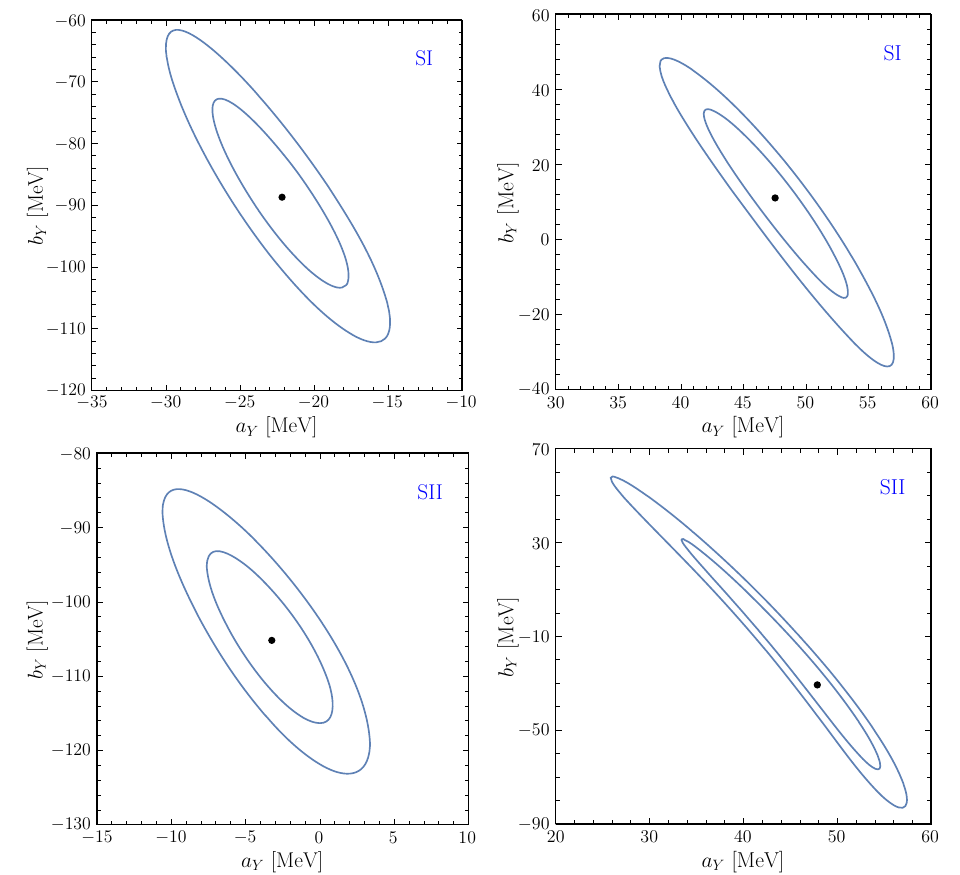
Fig. 1 1 σ - and 2 σ -contours in the a Y − b Y parameter plane corre- sponding to 68.3 and 95.4% C.L. for the scenario I (SI) in the top two frames and scenario II (SII) in the bottom two frames. The dot in each